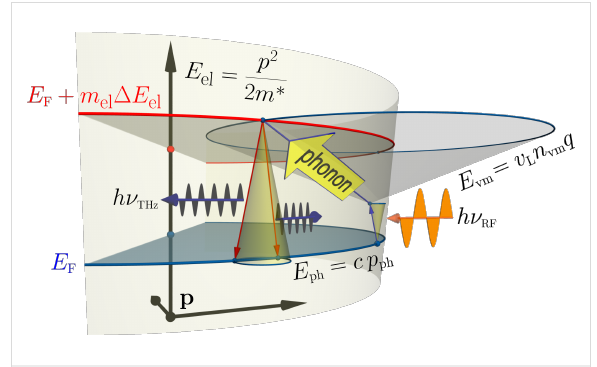
Figure 1: Scheme of absorption of microwave radiation h ν RF by an electron at E F , assisted by an absorption of a longitudinal phonon, with subsequent emission of a terahertz quantum h ν THz . The correspond- ing dispersion laws are indicated. See text for details.